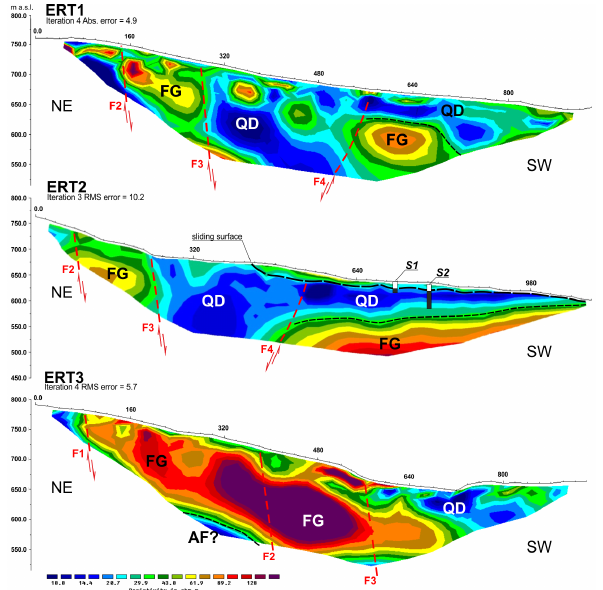
Figure 3. Resistivity models (see Fig. 2 for the location of ERT profiles).